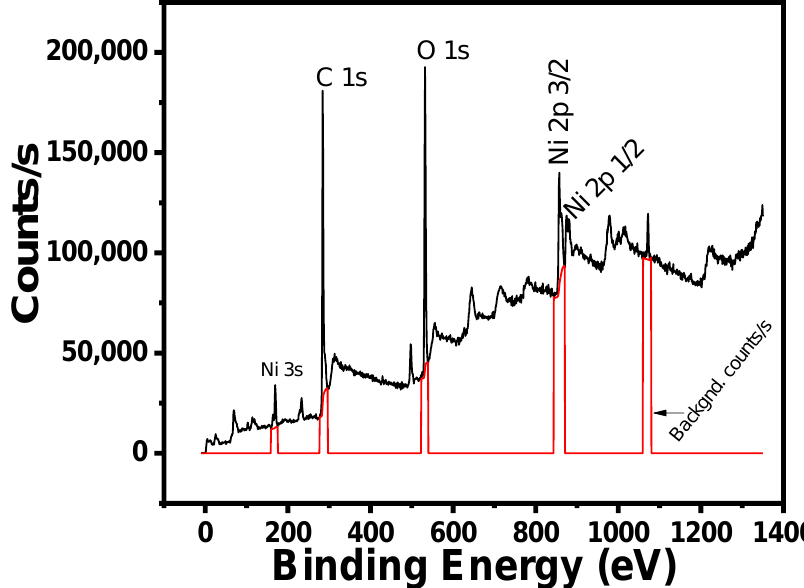
Figure 2. XPS spectrum of the CNT and NiPc composite showing the presence of Ni, C and